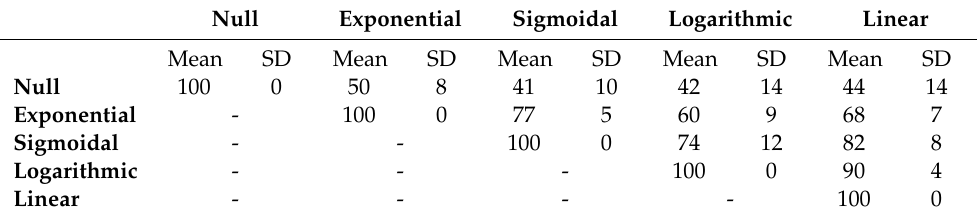
Table 4. Sensitivity analysis results comparing the functional connectivity current maps generated under each resistance scenario. Across species means and standard deviations for the pairwise comparisons of the percentage of overlapping high current cells. Percent overlap was calculated by comparing the locations of cells with the highest 20% current, after excluding the highest 5%.